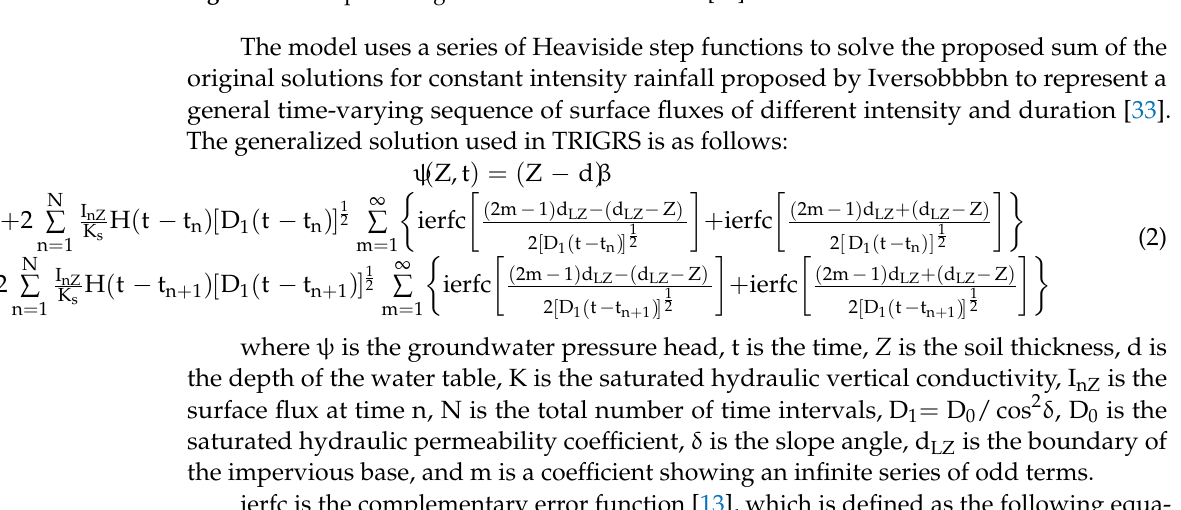
Figure 1. Conceptual diagram of the TRIGRS model